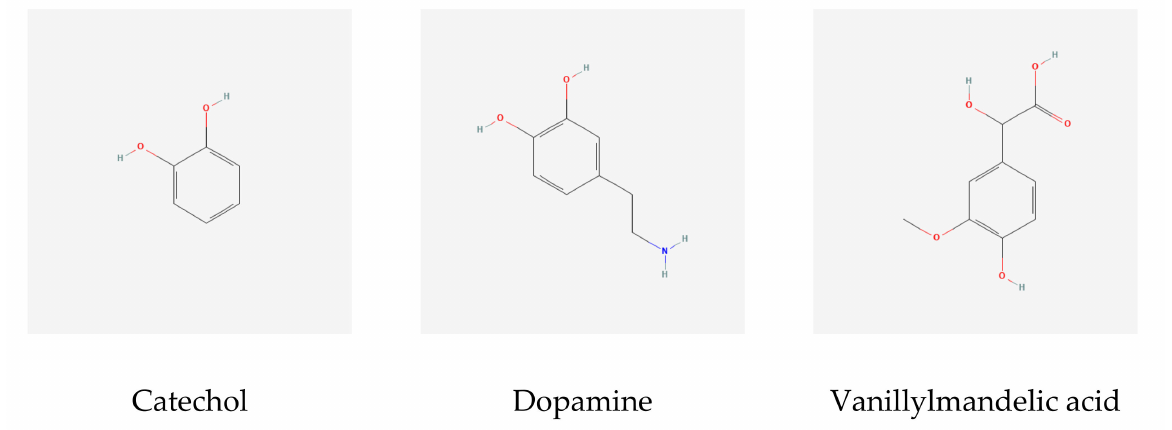
Figure 2. Chemical structures of key molecules discussed in this paper (images from PubChem https://pubchem.ncbi.nlm.nih.gov/, accessed on 15 March 2022).